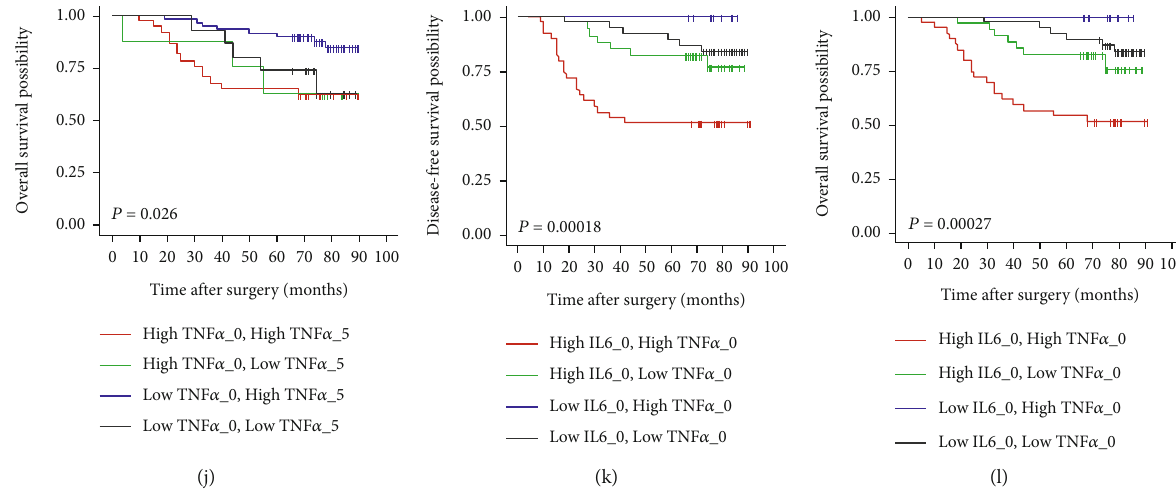
Figure 2: (a) The comparison of DFS between high and low IL6_0 levels. (b) The comparison of OS between high and low IL6_0 levels. (c) The comparison of DFS between high and low IL6_5 levels. (d) The comparison of OS between high and low IL6_5 levels. (e) The comparison of DFS between high and low TNF α _0 levels. (f) The comparison of OS between high and low TNF α _0 levels. (g) The combination analysis of IL6_0 and IL6_5 in DFS. (h) The combination analysis of IL6_0 and IL6_5 in OS. (i) The combination analysis of TNF α _0 and TNF α _5 in DFS. (j) The combination analysis of TNF α _0 and TNF α _5 in OS. (k) The combination analysis of IL6_0 and TNF α _0 in DFS. (l) The combination analysis of IL6_0 and TNF α _0 in ( P = 0 : 031 , Figure 2(c)), but the impact on OS were not able to reach statistical signi fi cance with P = 0 : 052 (Figure 2(d)). ( P = 0 : 0012 , Figure 2(e)) and OS ( P = 0 : 0019 , Figure 2(f)).